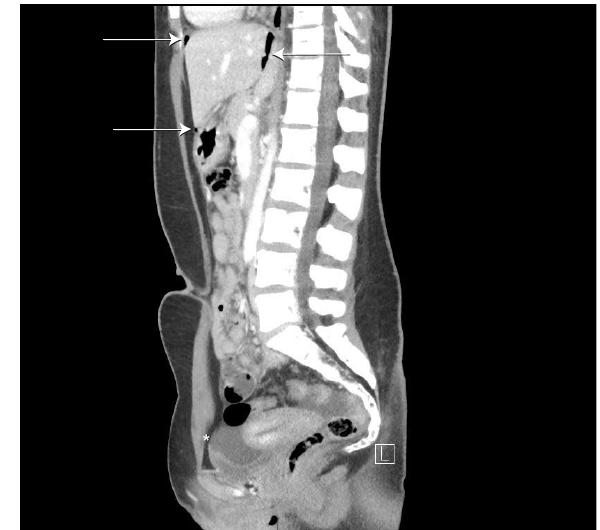
Image 1. Axial CT image demonstrating free air (arrows) in superior abdomen.